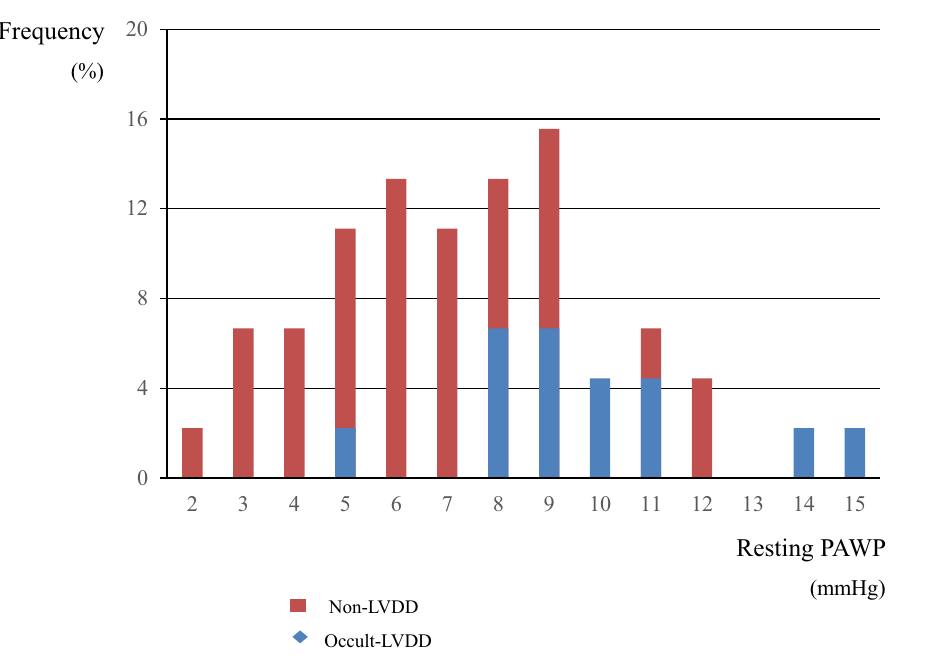
Figure 2. Distributions of the resting PAWP and exercise PAWP elevation. LVDD, left ventricular diastolic dysfunction; PAWP, pulmonary artery wedge